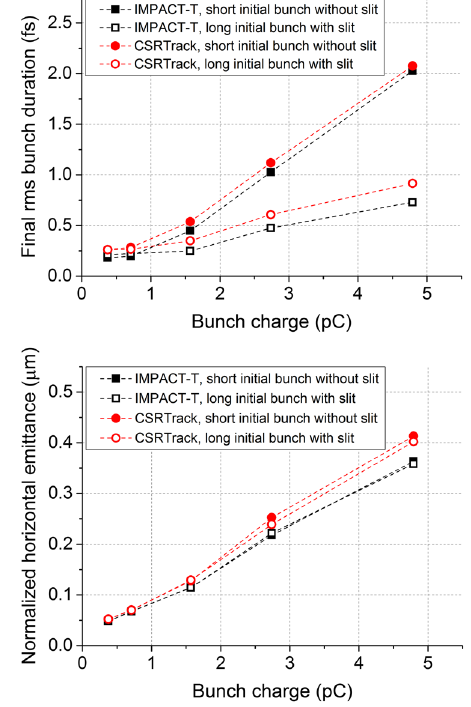
FIG. 12. Comparisons of the final rms bunch durations (up) and horizontal emittances (down) simulated by IMPACT - T and CSRT rack with different initial